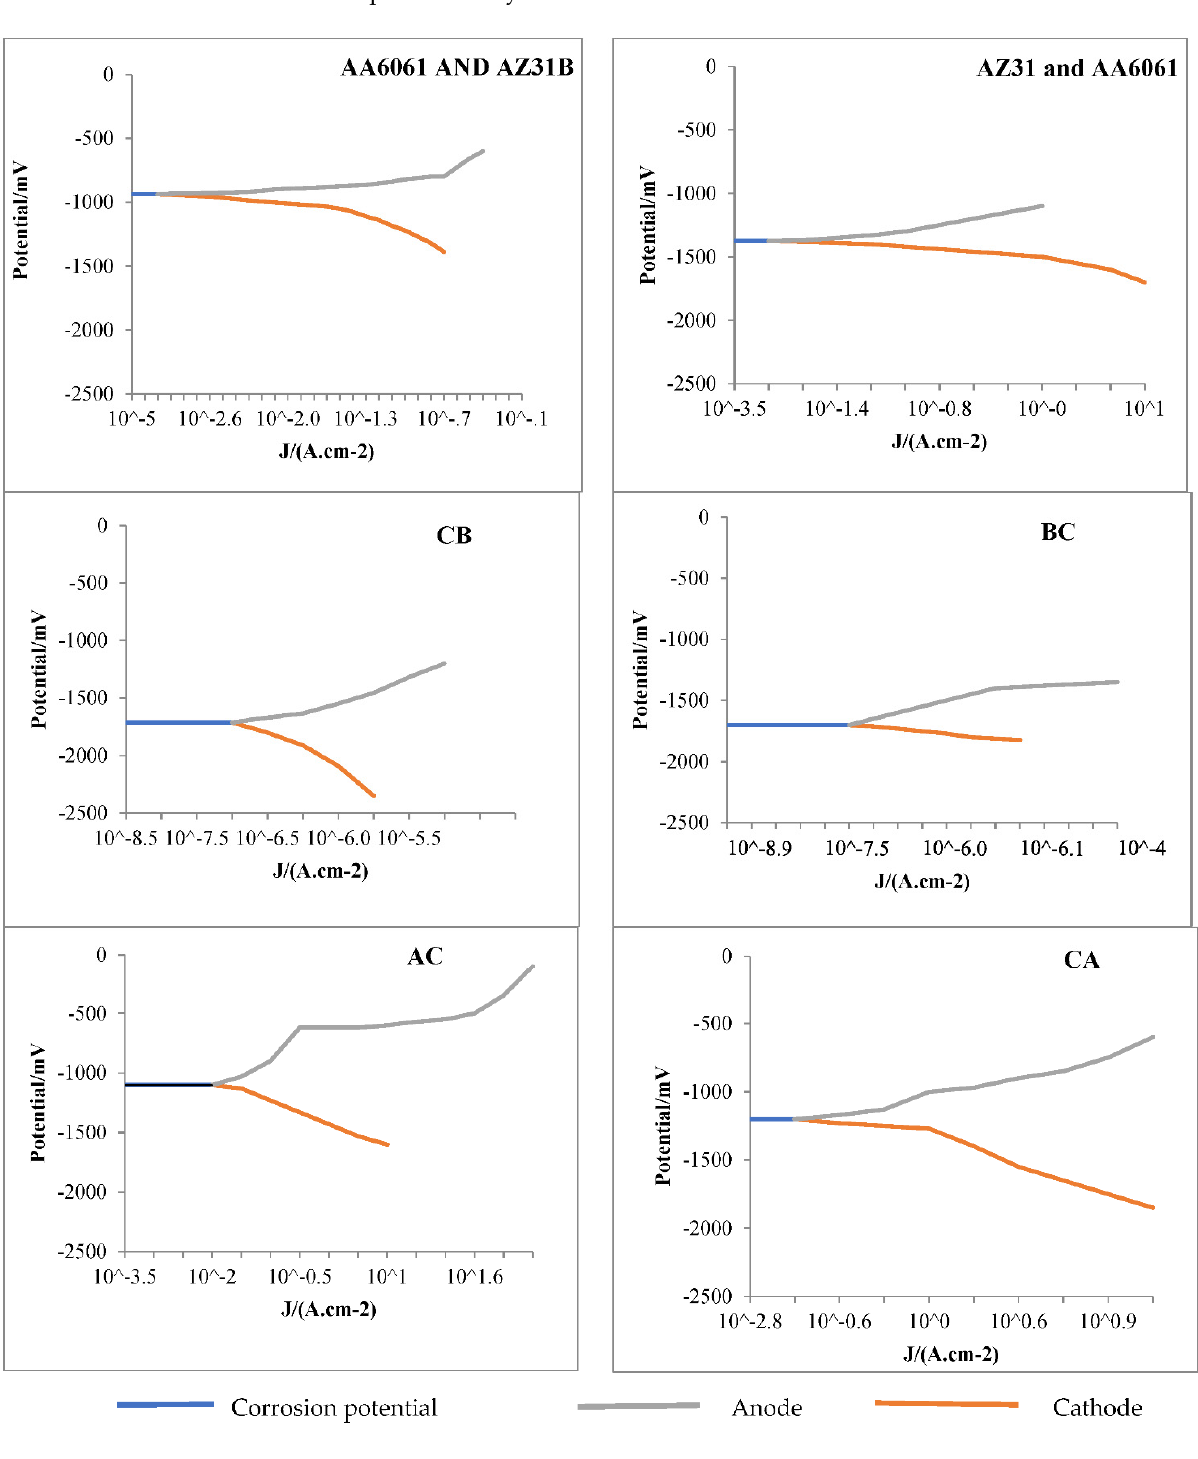
Figure 6. Potentiodynamic polarization curves of the dissimilar joints of FSW AA6061 and AZ31B, AZ31 and AA6061, AZ91 and AZ31B, AZ31B and AZ91, AA6061 and AZ91, and AZ91 and AA6061.